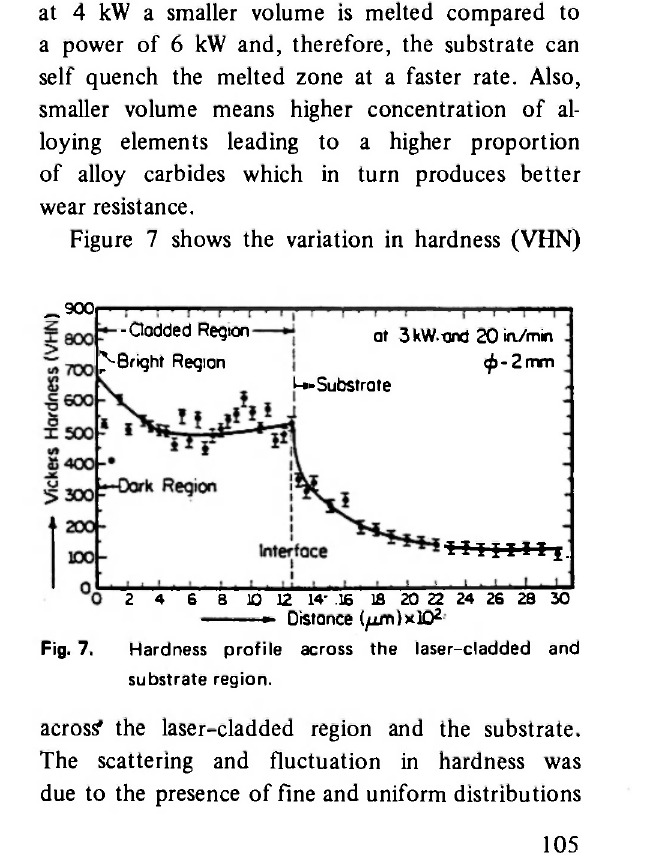
Fig. 7. Hardness profile across the laser-cladded and substrate region. acros? the laser-cladded region and the substrate. The scattering and fluctuation in hardness was due to the presence of fine and uniform